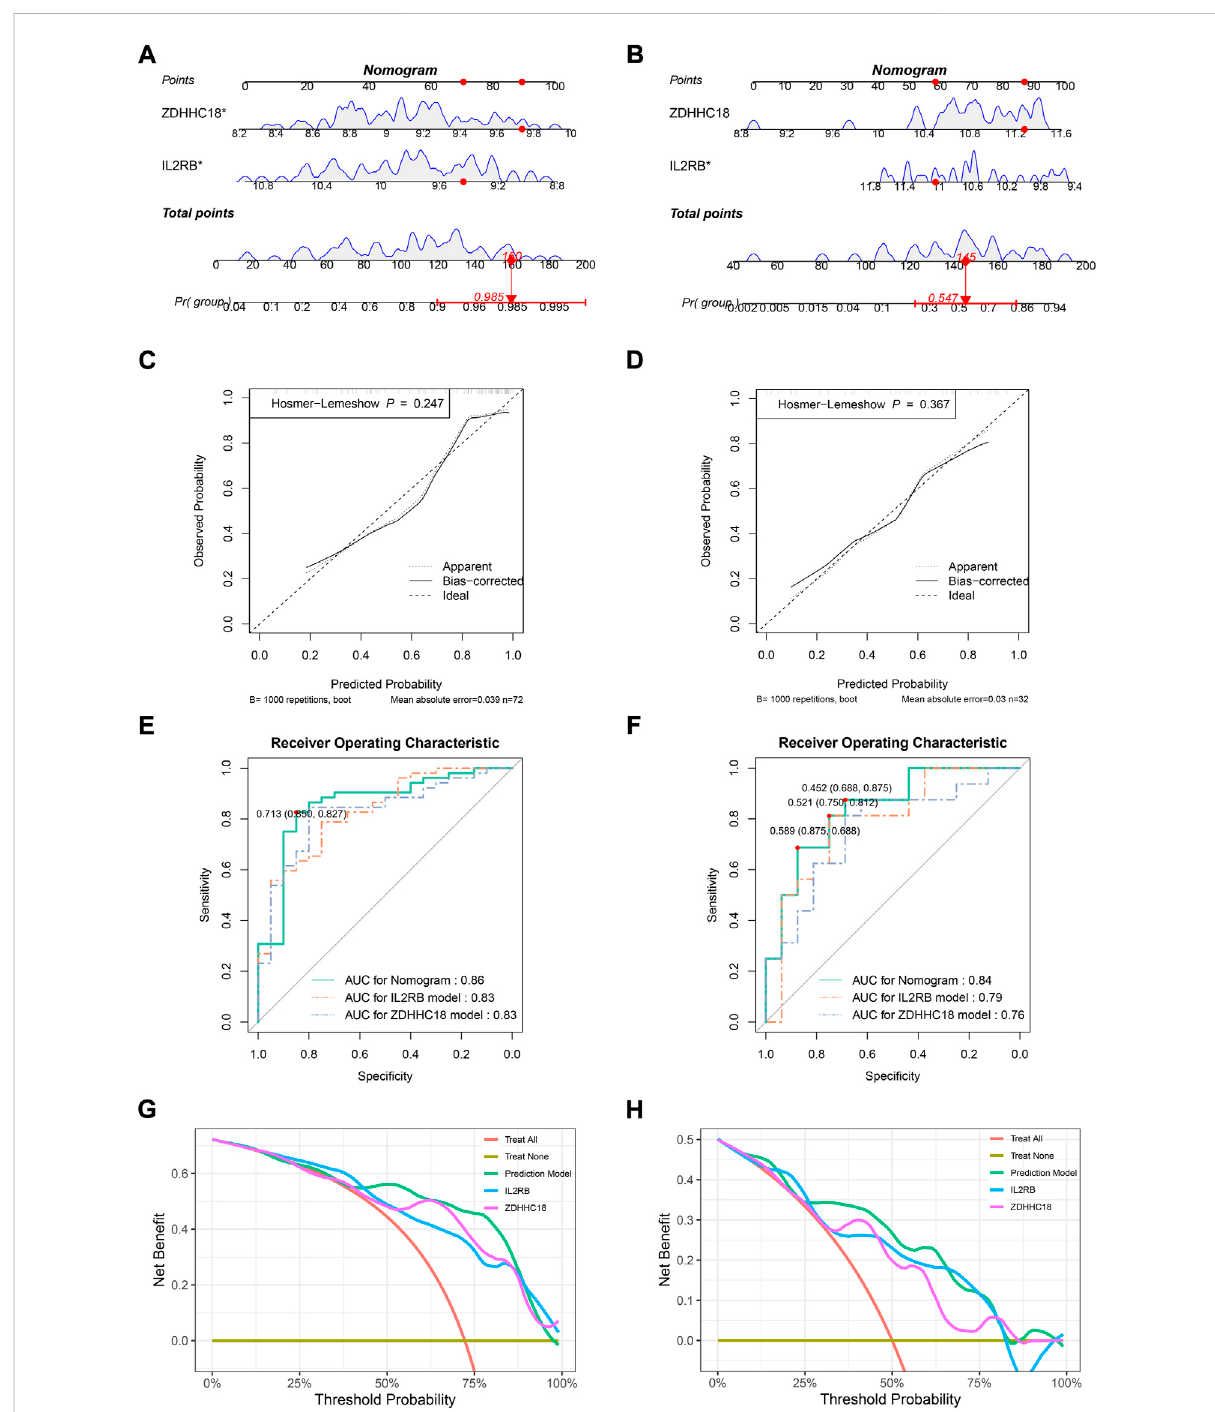
FIGURE 2 Evaluating the diagnostic model in the training set and a related validation set. Nomograms for the diagnostic model in GSE73754 (A) and GSE25101 (B) . Calibration plots for the diagnostic model in GSE73754 (C) and GSE25101 (D) : x -axis represents the predicted probability of AS by the model, while the y -axis represents theobserved probability of AS, the diagonal (dashed line) represents theideal status that thepredicted probability equaled the observed probability, and the solid and dotted lines represent the apparent and bias-corrected statuses of the predicted and observed probabilities, respectively. ROC plots for the diagnostic model in GSE73754 (E) and GSE25101 (F) : the x -axis represents 1-speci fi city of the model, while the y -axis represents the sensitivity of the model. DCA in GSE73754 (G) and GSE25101 (H) : the x -axis represents the threshold probability for the treatment or intervention, while the y -axis represents the net bene fi